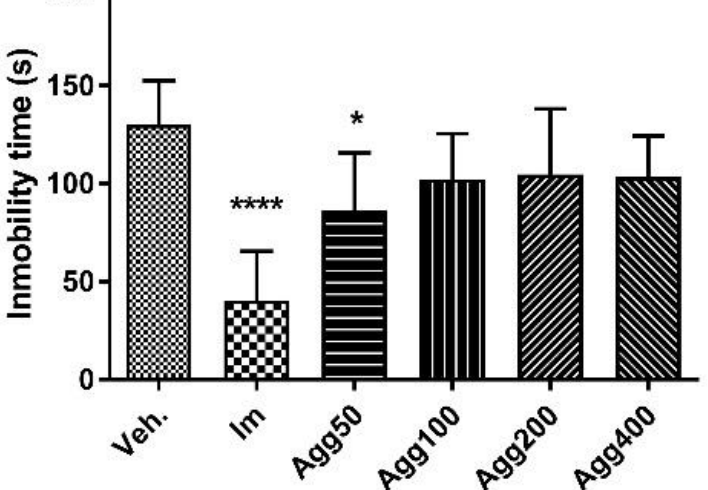
Figure 2. Immobility time (s) in the tail suspension test for the groups ( n = 6) treated orally for 7 days with Aloysia gratissima var. gratissima (Agg). Im.: imipramine. Veh: tween 80, 10%. The data correspond to the mean ± SD. One-way ANOVA and Dunnett’s post hoc test were performed. * p < 0.05; **** p < 0.0001.